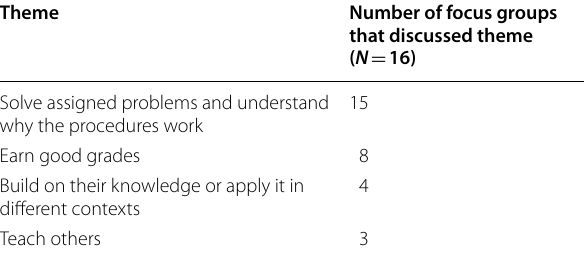
Table 3 Frequency of focus groups that discussed themes Theme Number of focus groups that discussed